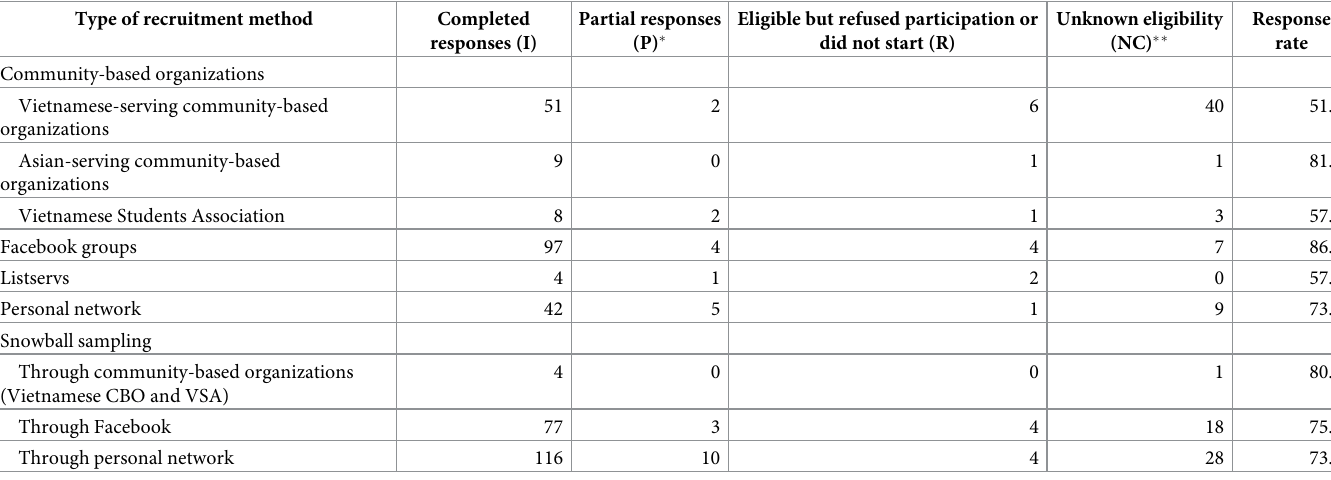
Table 1. Responses and response rates among recruitment